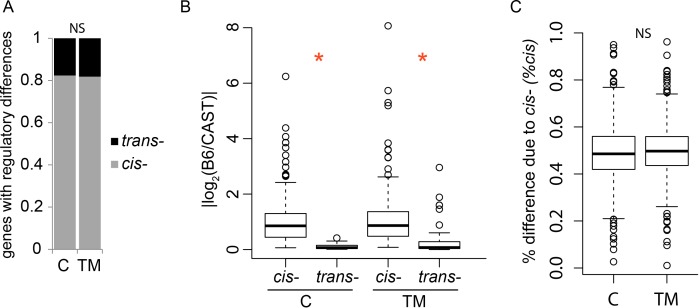
ER stress does not alter the regulatory landscape between B6 and CAST.(A) Distribution of genes that display a cis- or trans-regulatory difference between B6 and CAST under control and TM conditions. There is no significant change in the proportion of cis-regulatory differences between conditions. (B) The magnitude of the regulatory difference between B6 and CAST. Under both conditions, the cis-regulatory differences are larger than trans-regulatory differences (*, control: p < 3.746×10-8; TM: p < 0.03). (C) The amount of divergence between B6 and CAST attributable to cis-differences is not affected by TM. NS: not significant. C: control. TM: tunicamycin. For boxplots in (B) and (C) the boxes represent the interquartile range, the whiskers represent 1.5X interquartile range, and open circles are outliers.